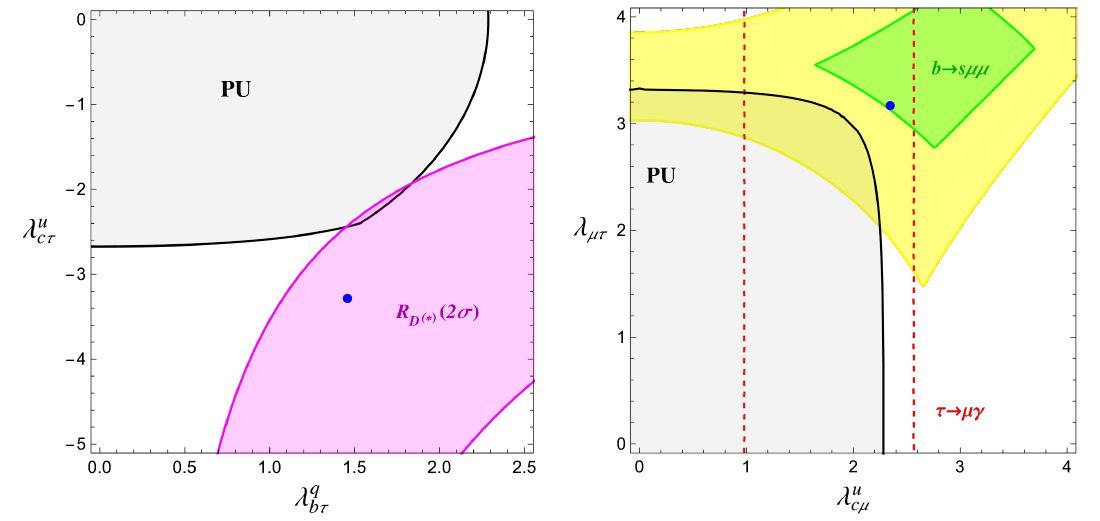
Figure 7 . Left: in gray we show the allowed region from PU and in purple the region compatible with R at 2 σ . The best fit point in [76] is shown in blue. Right: in gray we show the allowed D ( ∗ ) region from PU while in green and yellow the regions compatible with R tively. Between the dashed red lines constraints from τ → µγ are satisfied. The best fit point in [76] is shown in